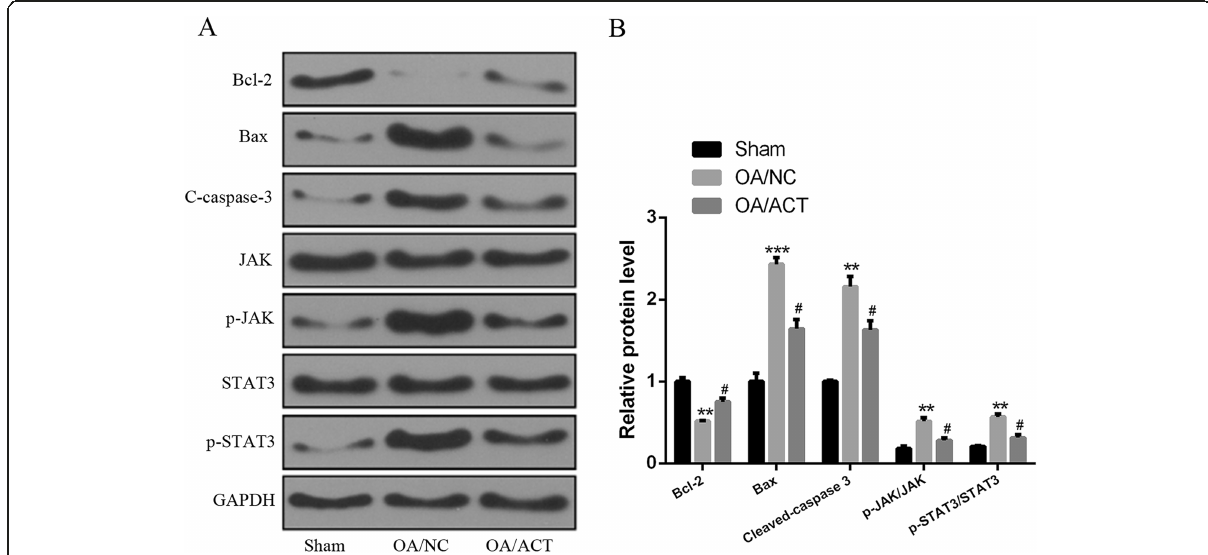
Fig. 6 ACT protects cartilage in surgery-induced OA rat. SD rats were surgery-stimulated to induce OA and treated with ACT (100 mg/kg, i.p. injection). a , b The expressions of Bcl-2, Bax, Cleaved-caspase3, JAK, p-JAK, STAT3 and pSTAT3 in the tibial cartilage was measured by western blotting. Results were repeated three times and representative data was shown. *** p < 0.001, and ** p < 0.01 compared with sham group. # p < 0.05 compared with OA/NC group